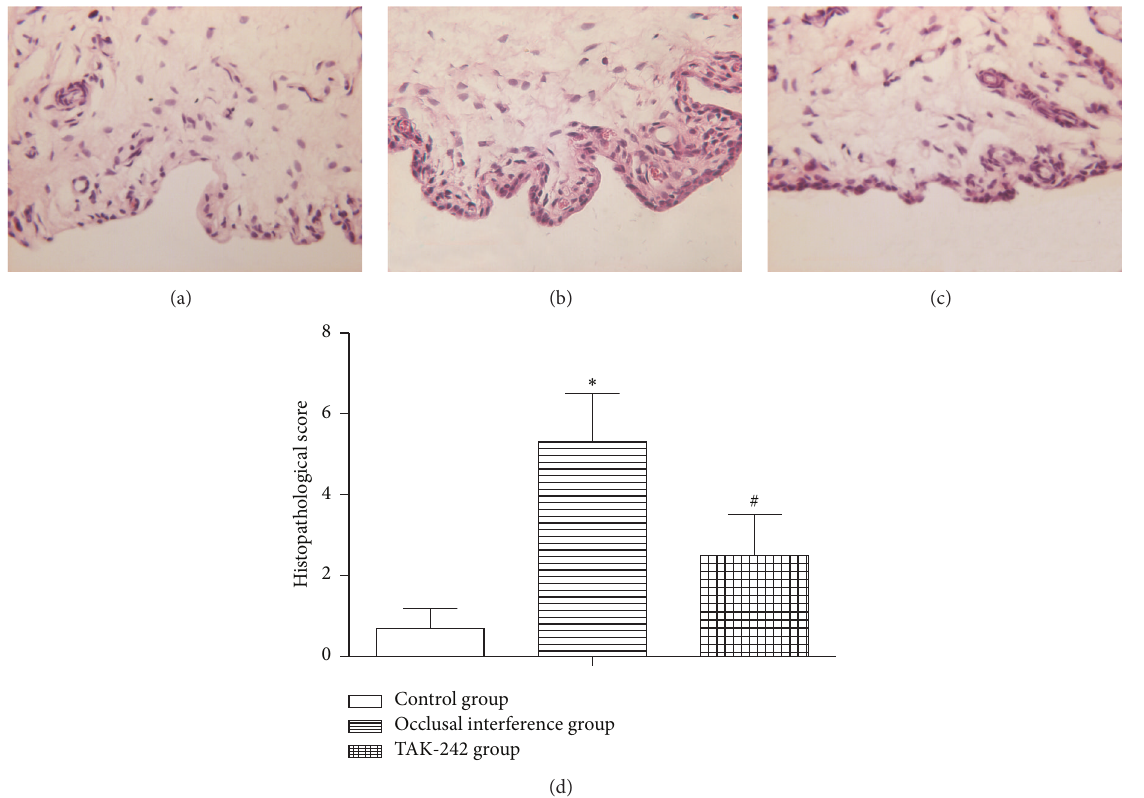
Figure 1: Histological examination of synovial membranes. (a) Control group. (b) Occlusal interference group. (c) TAK-242 group. (d) The histopathologicalscoreofeachgroup.Astheresultsshown,incomparisonwiththecontrolgroup,thehistopathologicalscorewassignificantly increasedintheocclusalinterferencegroup.However,thiseffectcouldbeinhibitedsignificantlyaftertreatmentwiththeTAK-242.Datashows all the values from independent samples of 𝑛 = 6 , ∗ 𝑃 < 0.05 versus control group and # 𝑃 < 0.05 versus occlusal interference